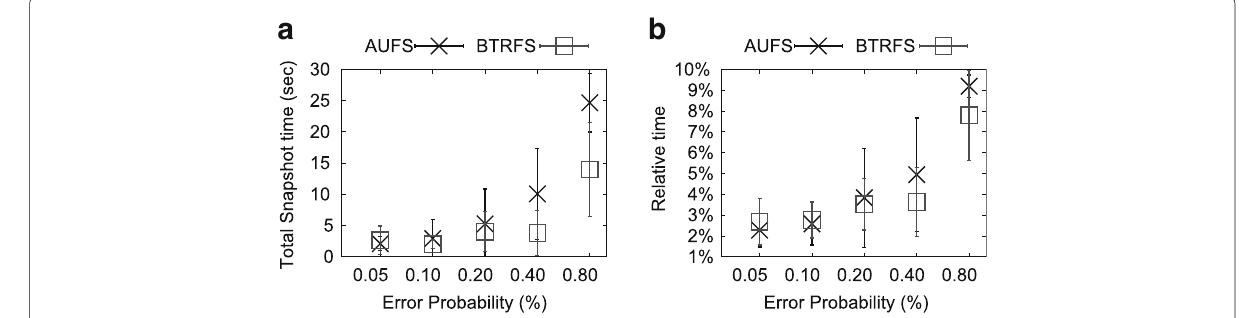
Fig. 10 Overhead of AUFS and BTRFS for Wordpress. a Total Snapshot Time. b Relative